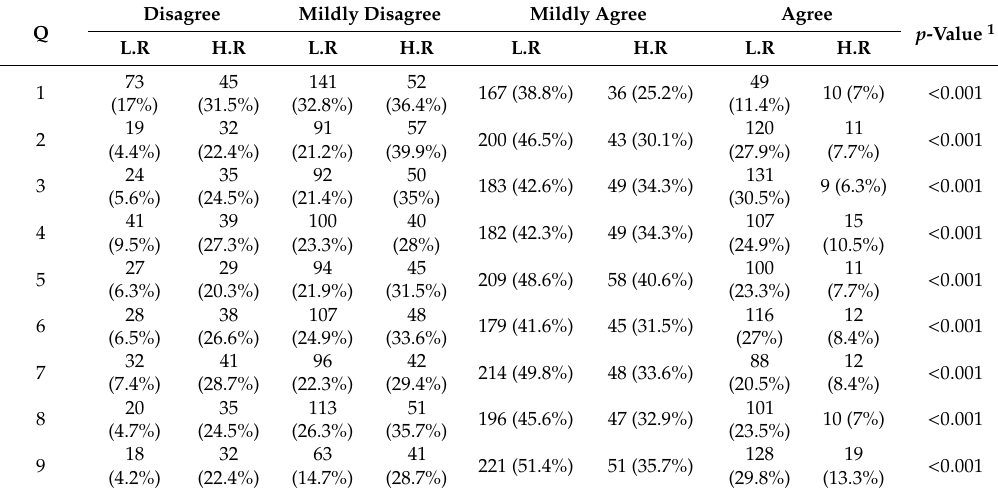
Table A6. Frequency of the Positive Mental Health Scale (PMH) in low-risk (L.R) and high-risk (H.R) groups (Cut-o ff =